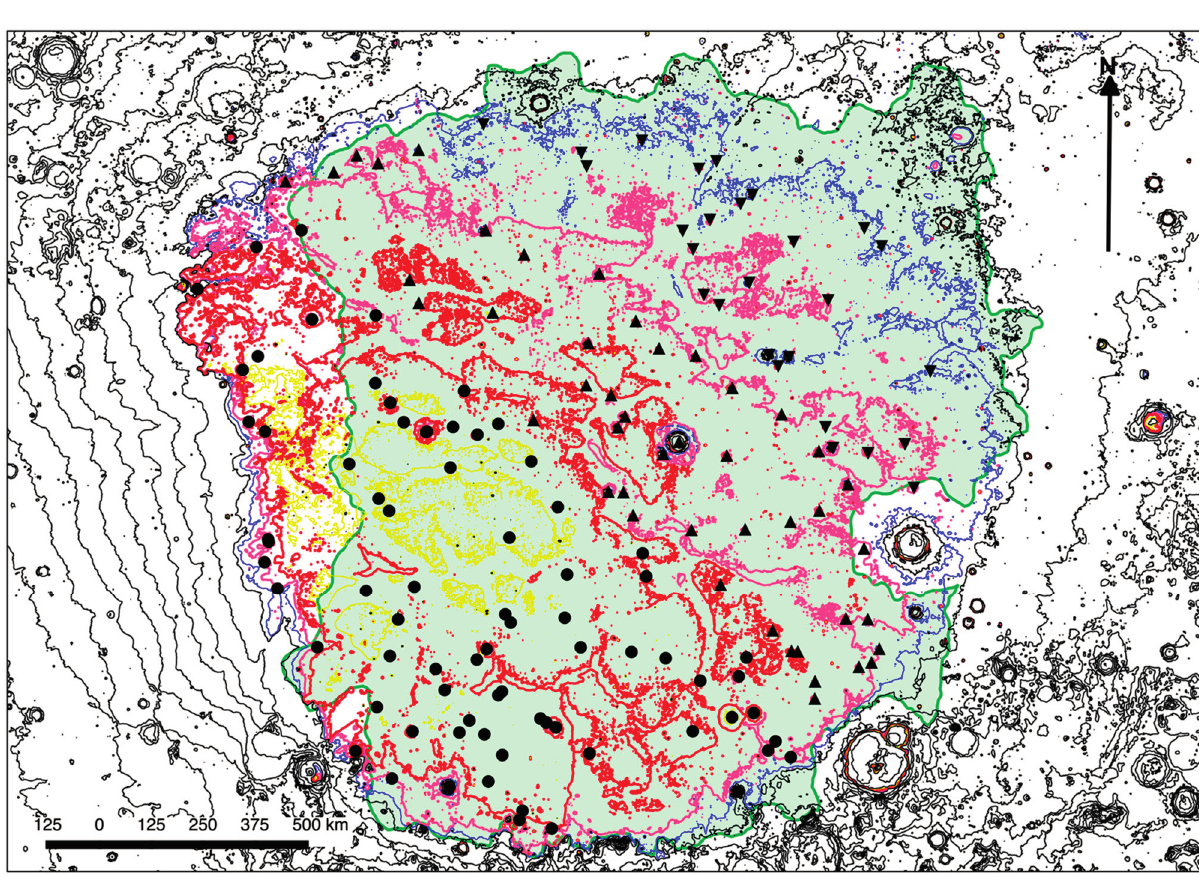
Figure 4. Geographical distribution of impact craters (black symbols). North is indicated by the arrow. The extent of unit lHl , represented by the light green polygon, is shown for reference. The topography of the region is indicated by contour lines calculated from MOLA MEGDR, with a contour interval of 500 m. In the interior of Isidis Planitia the isolines corresponding to elevations of − 3600 m (blue), − 3700 m (pink), − 3800 m (red) and − 3900 m (yellow) are shown. In the center of the basin the − 3800 m and − 3700 m contour lines run almost linearly and parallel to a NE-SW direction. These sections of the contour lines were used to subdivide the impact craters into three sectors: northeast (between − 3600 m and − 3700 m elevation), center (between − 3700 m and − 3800 m), and southwest (elevations lower than − 3800 m). The impact crater symbols are circles (southwestern sector of Isidis basin), triangles (central sector), and downward triangles (northeastern sector), consistent with the shape of the data points in the diagram of Figure